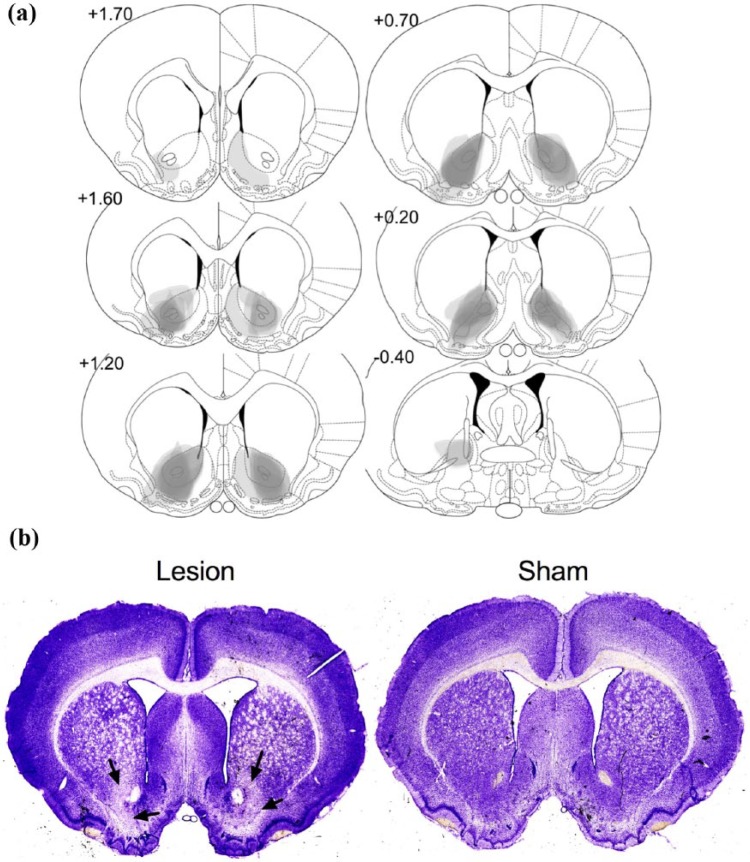
Histological analysis of NAc core lesions: (a) schematic diagrams of
NAc core lesions. Grey scale shading indicates extent of neuronal
loss across subjects, with each subject represented as a separate
stacked layer. Diagrams are modified from Paxinos and Watson (2005)
and (b) photomicrographs of cresyl-stained coronal sections,
depicting typical lesions of NAc core-lesioned (left) and
sham-lesioned (right) rats. Arrows indicate the site of lesion.